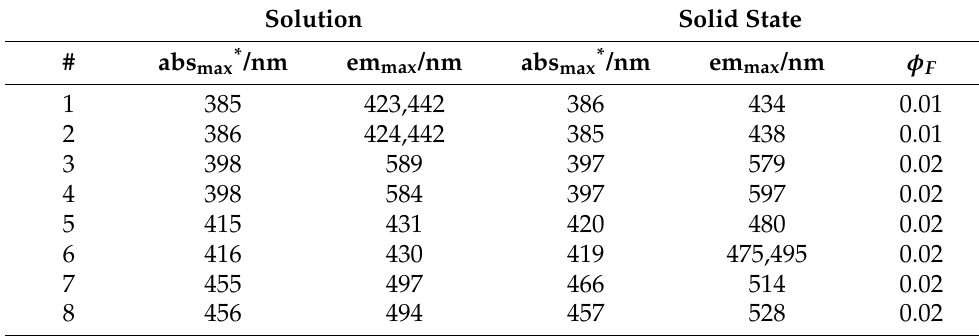
Table 2. The optical parameters of the